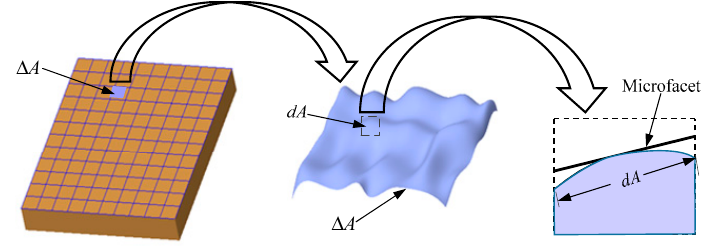
Figure 1. Microfacet model.